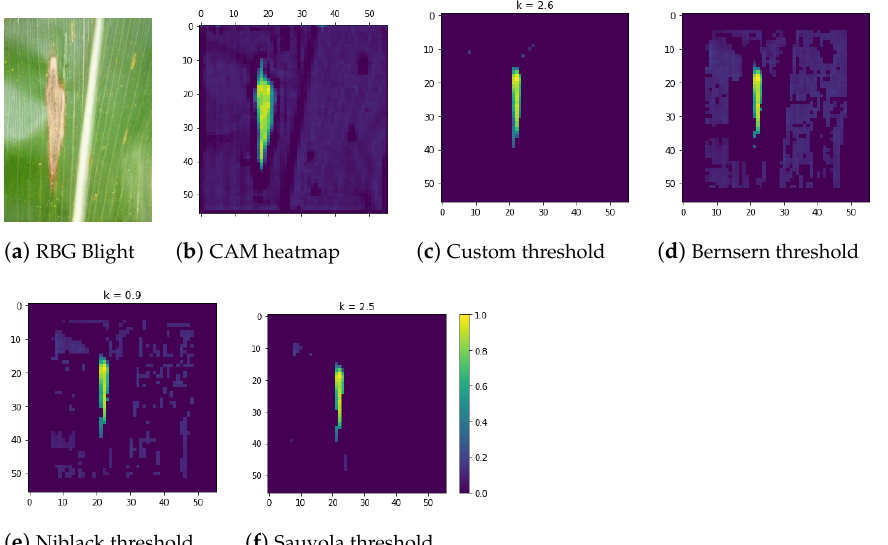
Figure 10. Results of various thresholding techniques on the CAM heatmap of an image of a Blight- infected leaf: ( a ) raw RGB color image of a leaf with Common Blight disease; ( b ) conv2D CAM